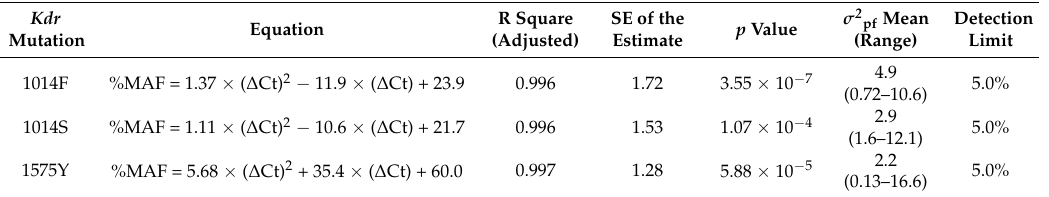
Table 1. Polynomial regression models for the detection of 1014F, 1014S, and 1575Y in mosquito pools (training